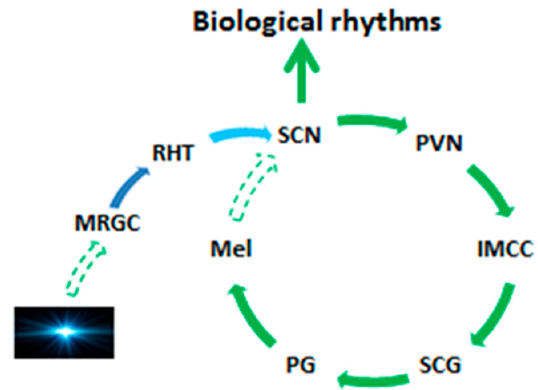
Figure 1. Illustration of the SCN-melatonin loop. Solid arrows indicate the neuronal connections and the direction of neuronal projections. Dash arrows indicate the input signals. SCN is the master clock which determines the biological rhythms as well as the melatonin circadian rhythm. Its intrinsic circadian interval is longer than 24 h. The natural photoperiod (photos) serves as an input signal to entrain melatonin circadian rhythm to 24 h; in turn, melatonin functions as a signal of photoperiod to re-entrain the biological rhythm of SCN to 24 h. MRGC: melanopsin-containing retinal ganglion cells; RHT: retino-hypothalamic tract; SCN: suprachasmatic nucleus; PVN: paraventricular nucleus; IMCC: Intermediolateral cell column; SCG: sympathetic cervical ganglion; PG: pineal gland. Mel: melatonin.